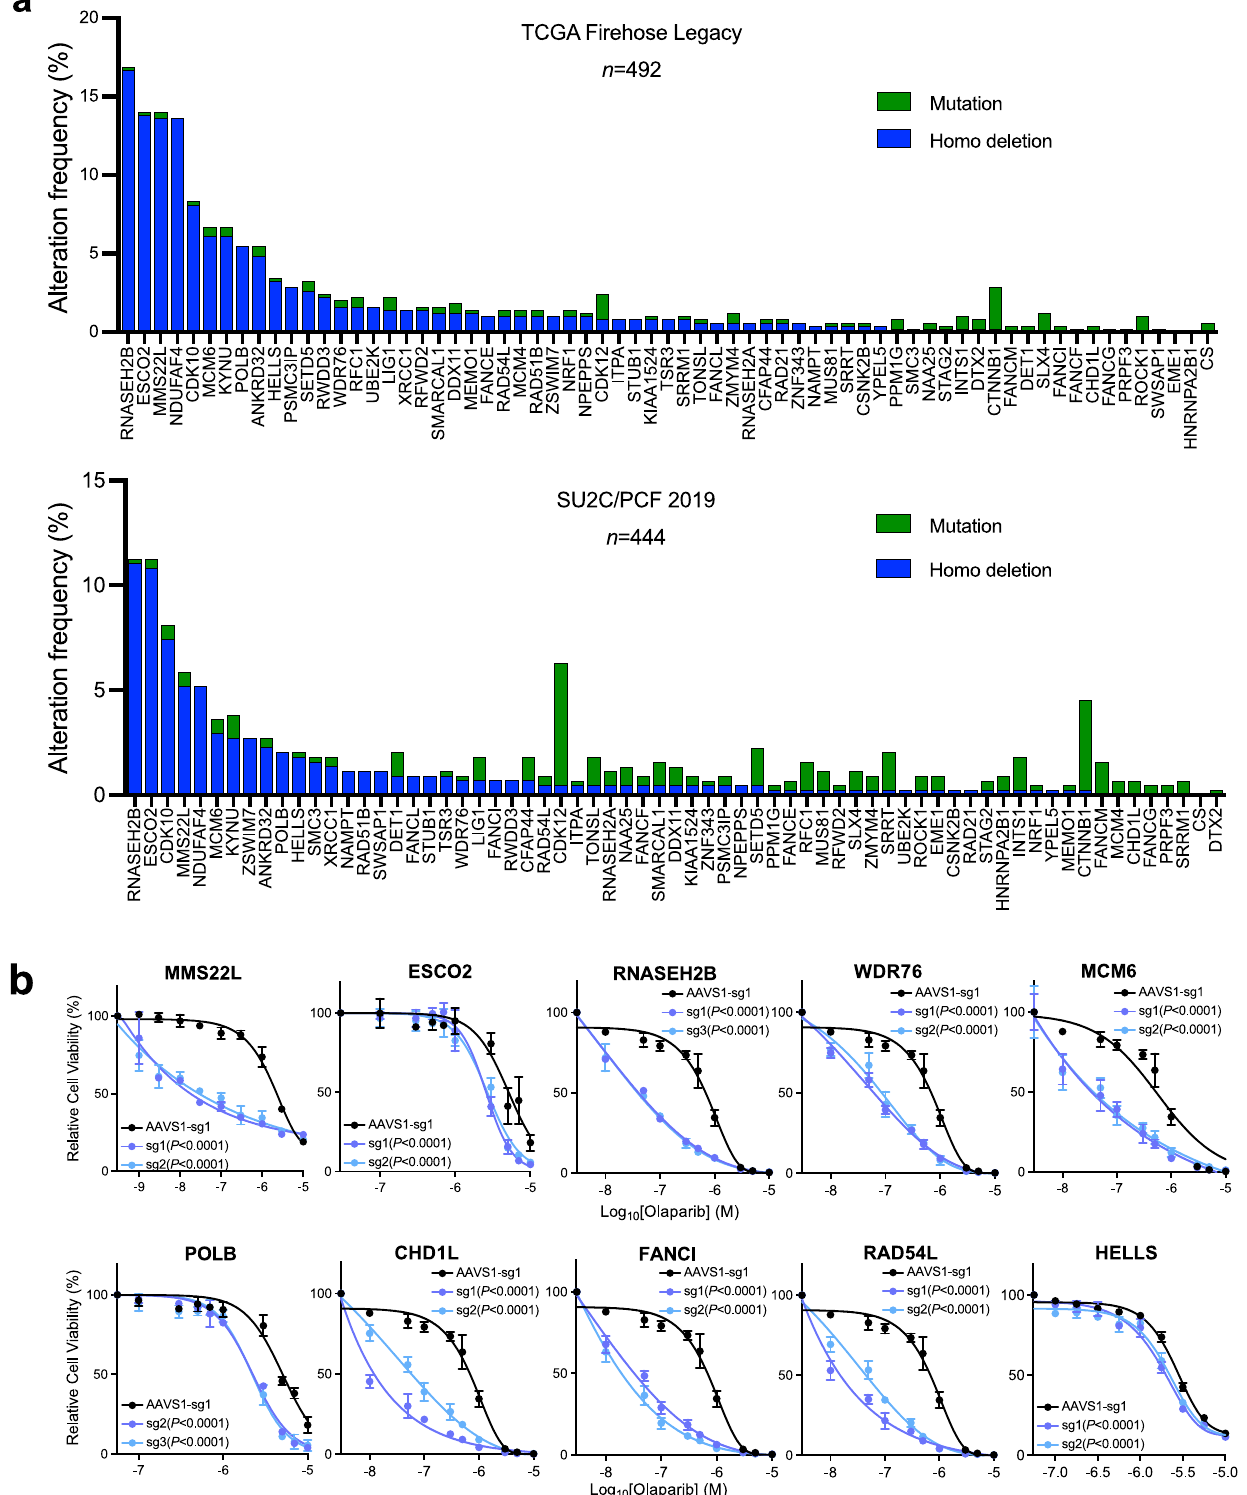
Fig. 2 | Validation of negatively selected genes with frequent genomic altera- tions. a The frequency of mutations and homozygous (Homo) deletions in 67 common negatively selected genes from the TCGA Firehose Legacy cohort(Upper panel, n =492) and the SU2C/PCF cohort (Lower panel, n =444) 25,26 . b Dose- response curves after treatment with olaparib for C4-2B cells with gene knockout